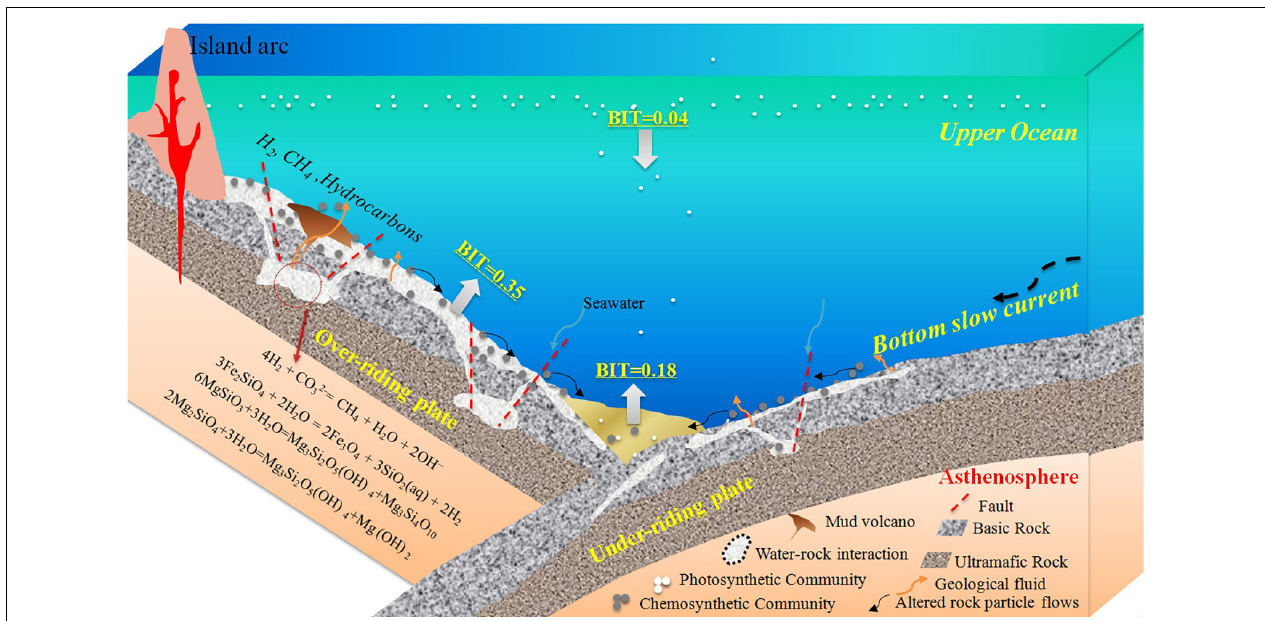
FIGURE 7 | A schematic model of the sources, production and transport of GDGTs in the trenches. Plate bending caused by subduction processes has generated numerous fractures, faults and microfissures both within the subduction slab and overriding plate, triggering water-rock interactions in the oceanic crust. These water-rock interactions facilitate the widespread growth of chemoautotrophic communities across the trench